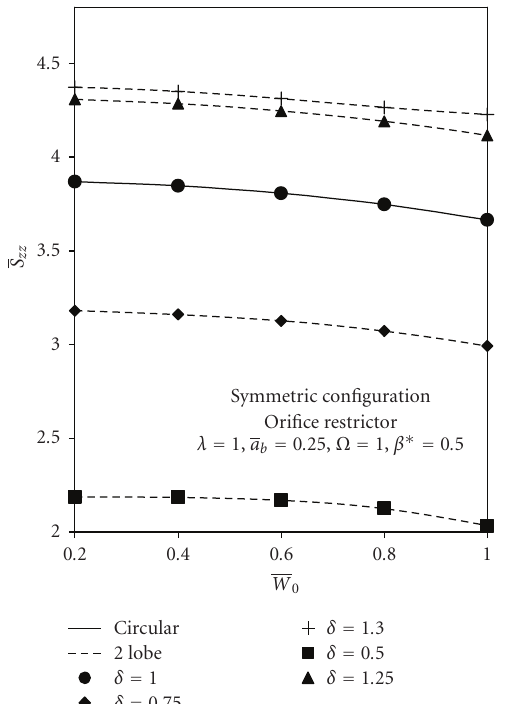
Figure 9: Variation of direct sti ff ness ( S zz ). Figure 10: Variation of cross coupled sti